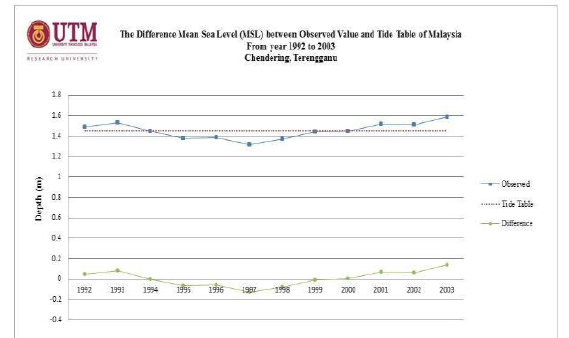
Figure 20. Graph of Difference Mean Sea Level (MSL) between Observed Value and Tide Table of Malaysia at Chendering, Terengganu.